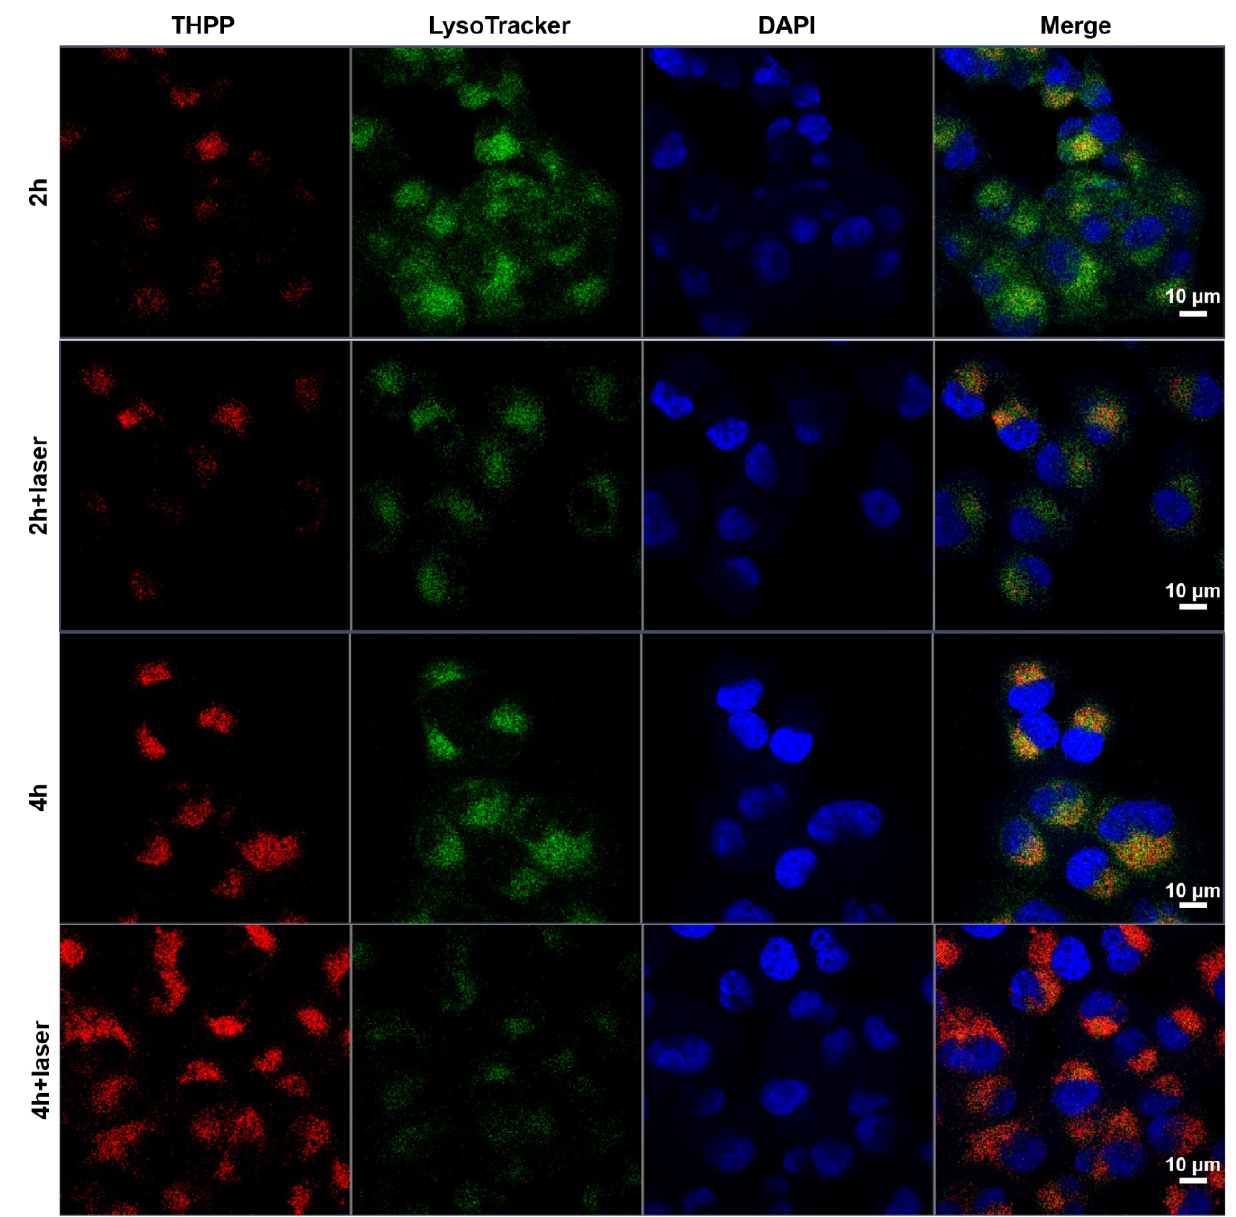
Figure 4. Lysosomal escape of TPG NPs. Confocal microscopy images of PANC-1 cells after treatment with TPG NPs for 2 – 4 h (with/without laser). Cells were stained with LysoTracker ( green ) and DAPI ( blue ) ( red : THPP; scale bar = 10 μm).